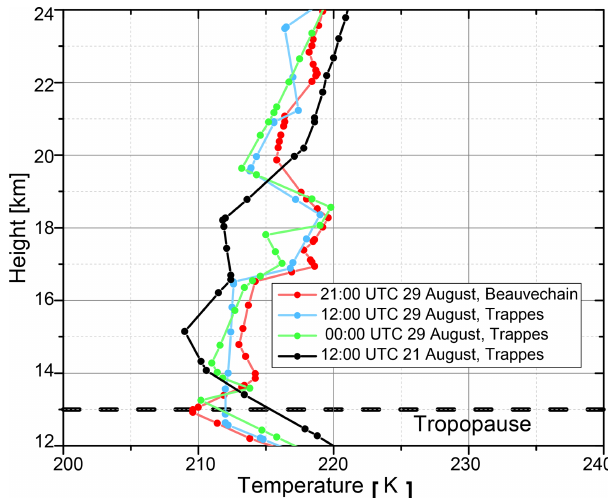
Figure 3. Temperature profiles from the radiosonde measurements. The green and cerulean lines are the temperature profiles of Trappes at 00:00 and 12:00UTC on 29 August 2017. The red line shows the Beauvechain data at 21:00UTC on 29 August 2017. The black line is for 12:00UTC on 21 August in Trappes. The horizontal dashed black line at 13km represents the approximate position of the